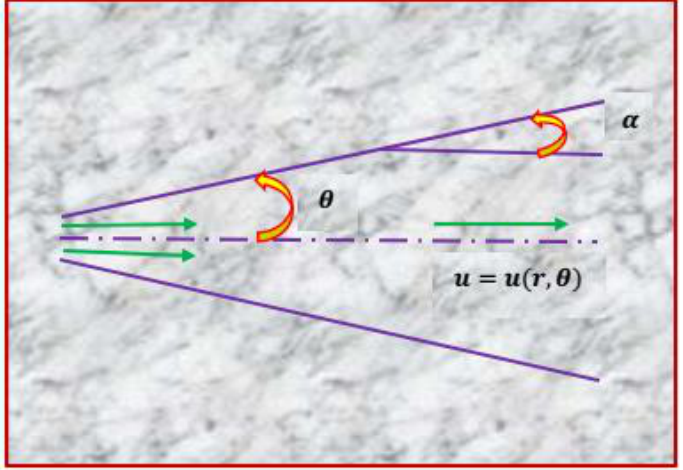
Figure 1. Pictorial view of flow configuration.